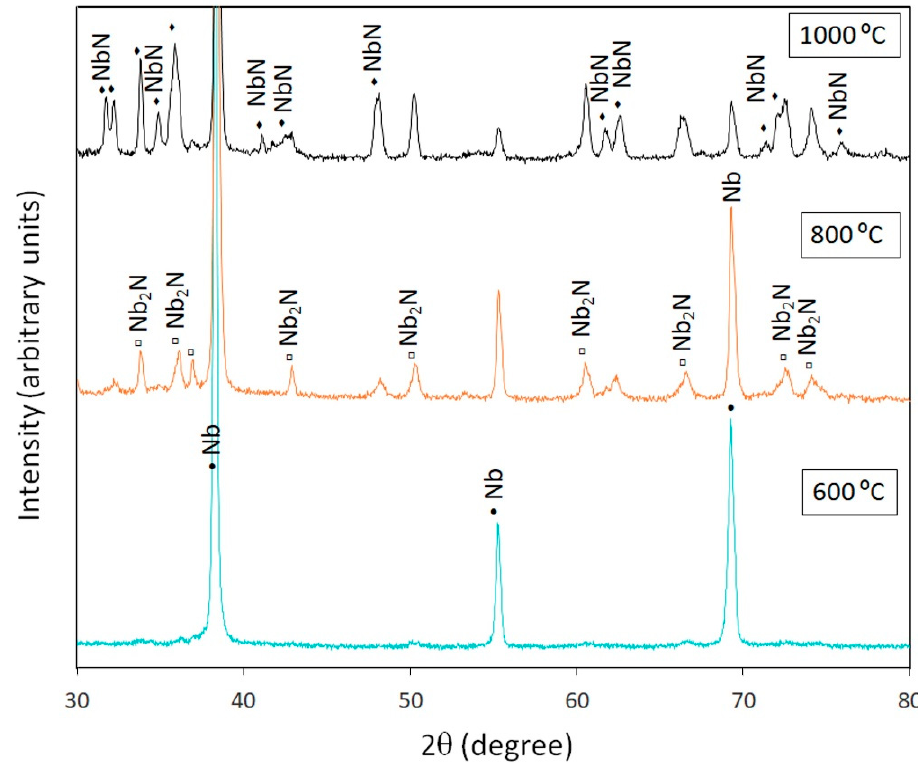
Figure 5. XRD patterns obtained for Nb powders nitrided under flowing NH 3 (1.14 mm·s − 1 ).